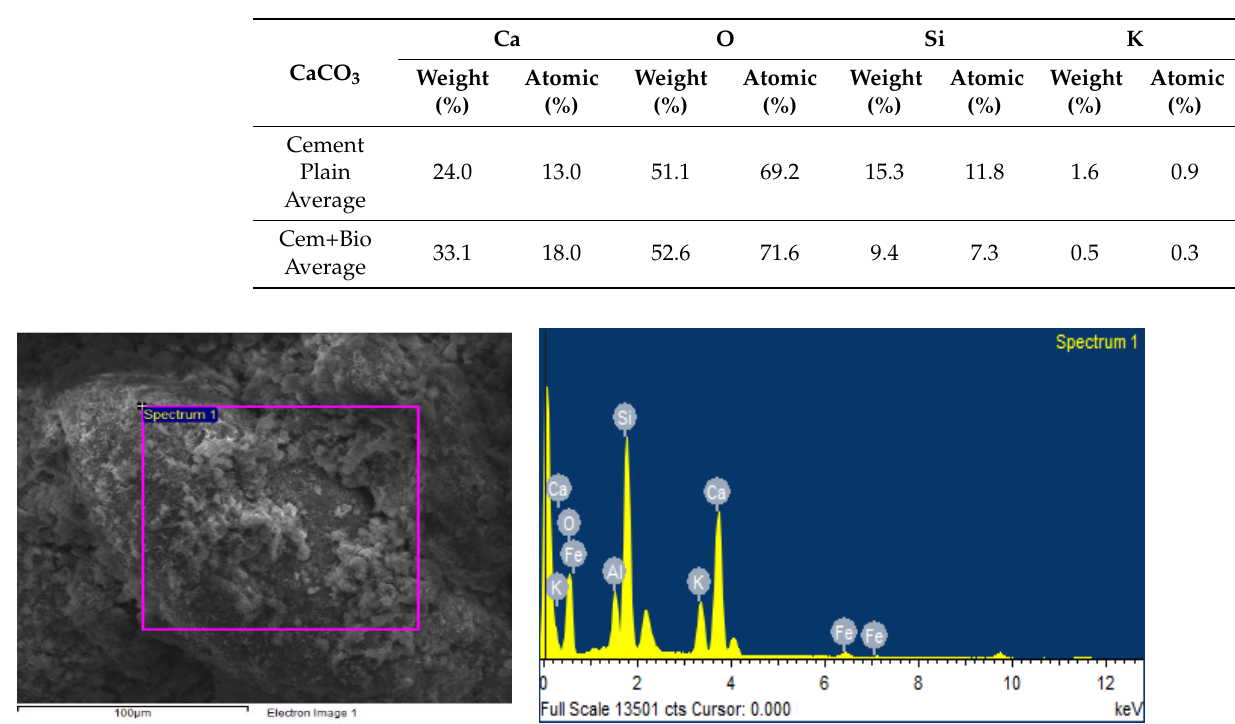
Figure 11. EDS of earth-based plain mortar.